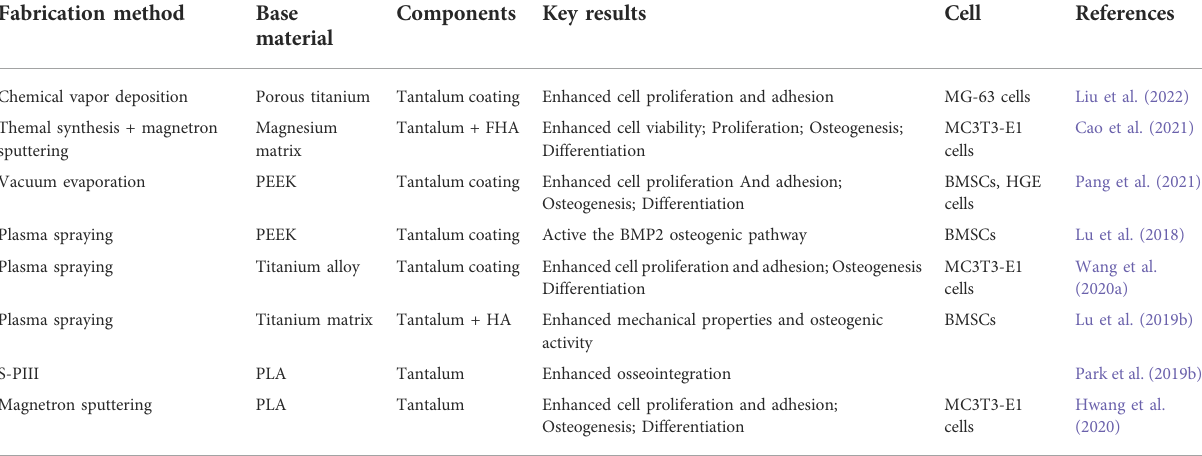
TABLE 1 Tantalum is combined with other factors to form a